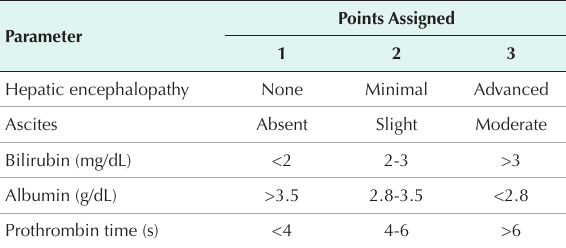
Points Assigned 1 2 3